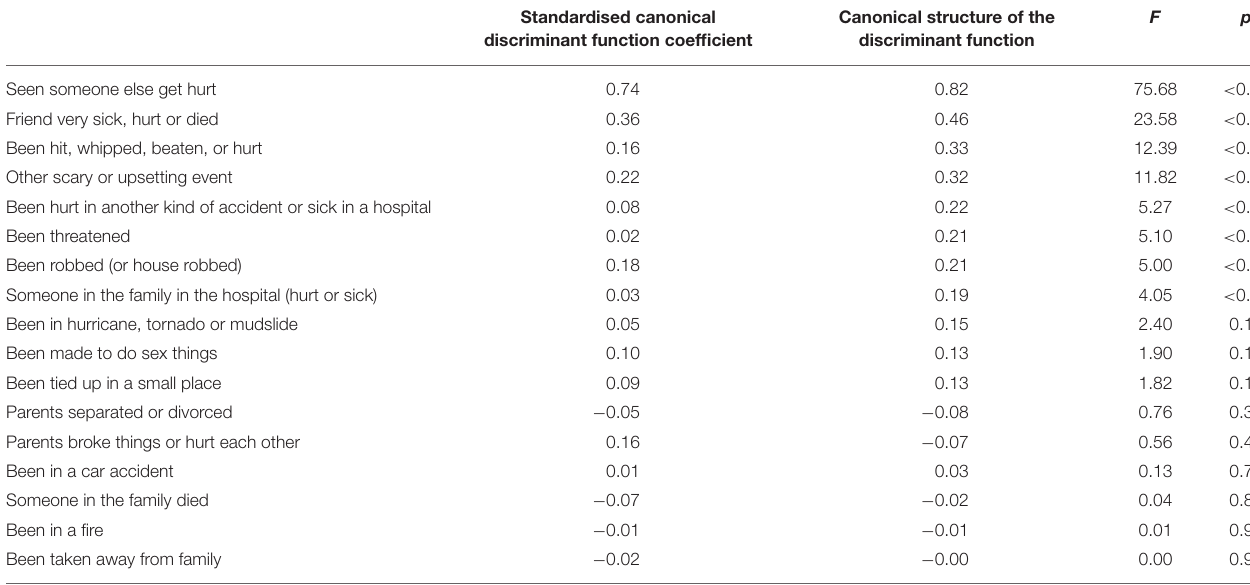
TABLE 8 | Summary of discriminant analysis measures ( N =